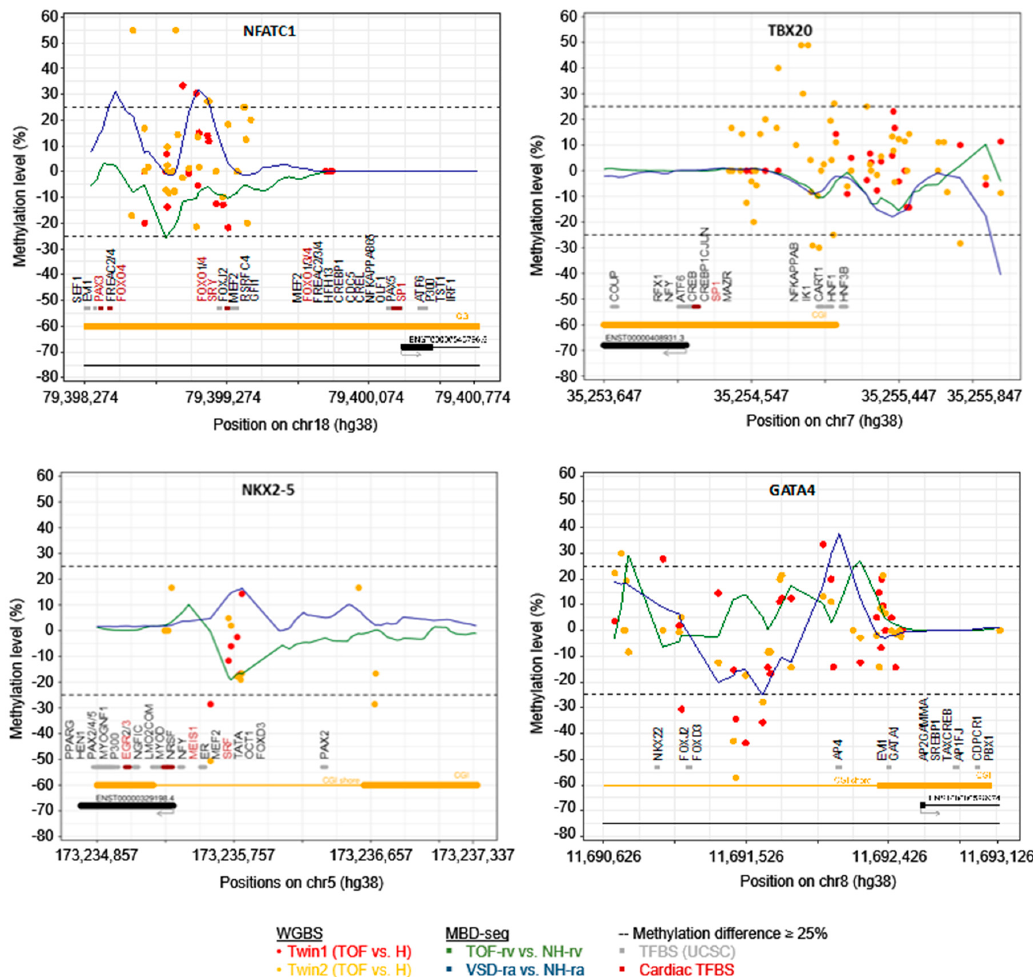
Figure 4. DNA methylation level at promoter regions of NFATC1, TBX20, NKX2-5 and GATA4 in healthy and a ff ected twins obtained by WGBS ( n = 1 each; coverage at CpGs ≥ 5 × ) as well as in right ventricular or atrial tissue of normal hearts and patients with TOF or VSD obtained by methyl-CpG binding domain protein-enriched genome sequencing (MBD-seq) ( n = 7 for TOF-rv; n = 8 for VSD-ra; n = 3 for NH-rv; n = 4 for NH-ra). Promoters are defined as − 2 kb /+ 500 bp of transcriptional start site. CGIs and CGI shores are indicated by orange line at the bottom. Moreover, binding sites of transcription factors (obtained from UCSC) are provided in gray or for cardiac factors in red. For WGBS, methylation at single CpG is provided. CGIs, CpG islands; NH, normal heart; H, healthy; RA, right atrium; RV, right ventricle; TFBS, transcription factor binding site; TOF, Tetralogy of Fallot; VSD, ventricular septal defect; WGBS, whole genome bisulfite sequencing.